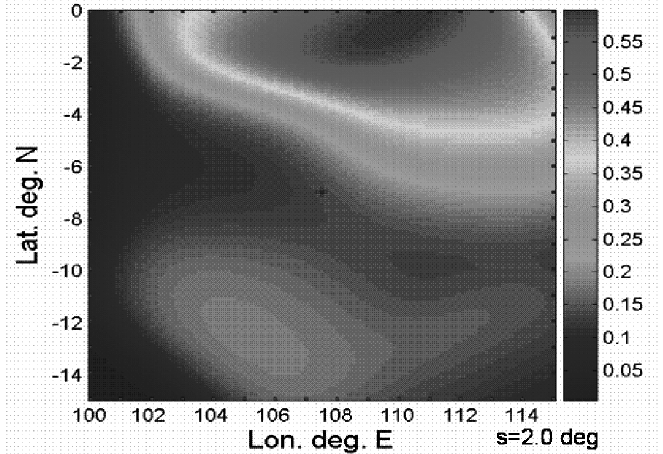
Fig. 19. S 4 maps based on measurements at the Bandung